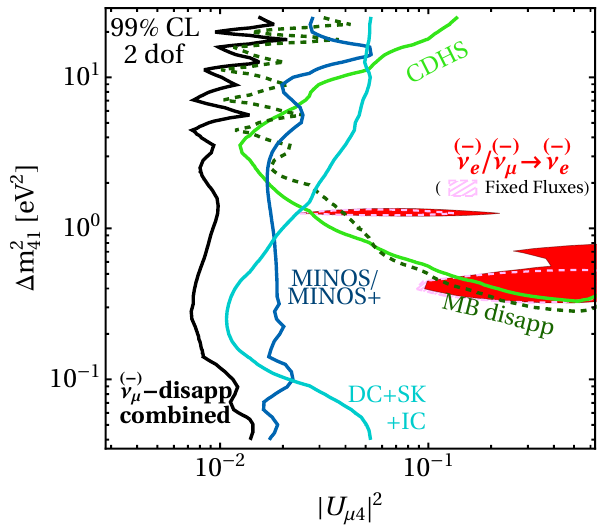
Figure 5 . Constraints on the 3 + 1 scenario from (cid:23) (cid:22) /(cid:22) (cid:23) (cid:22) disappearance. We show the allowed parameter regions, projected onto the plane spanned by the mixing matrix element j U (cid:22) 4 j 2 and the mass squared di(cid:11)erence (cid:1) m 2 . Note that the exclusion limit from NO (cid:23) A is still too weak to 41 appear in the plot. It is, however, included in the curve labelled \combined", which includes all data listed in table 4. The curve labelled DC+SK+IC combines all our atmospheric neutrino data; for this bound we have (cid:12)xed the parameters (cid:18) 12 ; (cid:18) 13 ; (cid:18) 14 but minimize with respect to all other mixing parameters, including complex phases. For comparison, we also show the parameter region favoured by (cid:23) e disappearance and (cid:23) (cid:22) ! (cid:23) e appearance data (using LSND DaR+DiF), projected onto the j U (cid:22) 4 j 2 {(cid:1) m 2 plane; we show the allowed regions for the analyses with (cid:12)xed and free reactor 41 neutrino